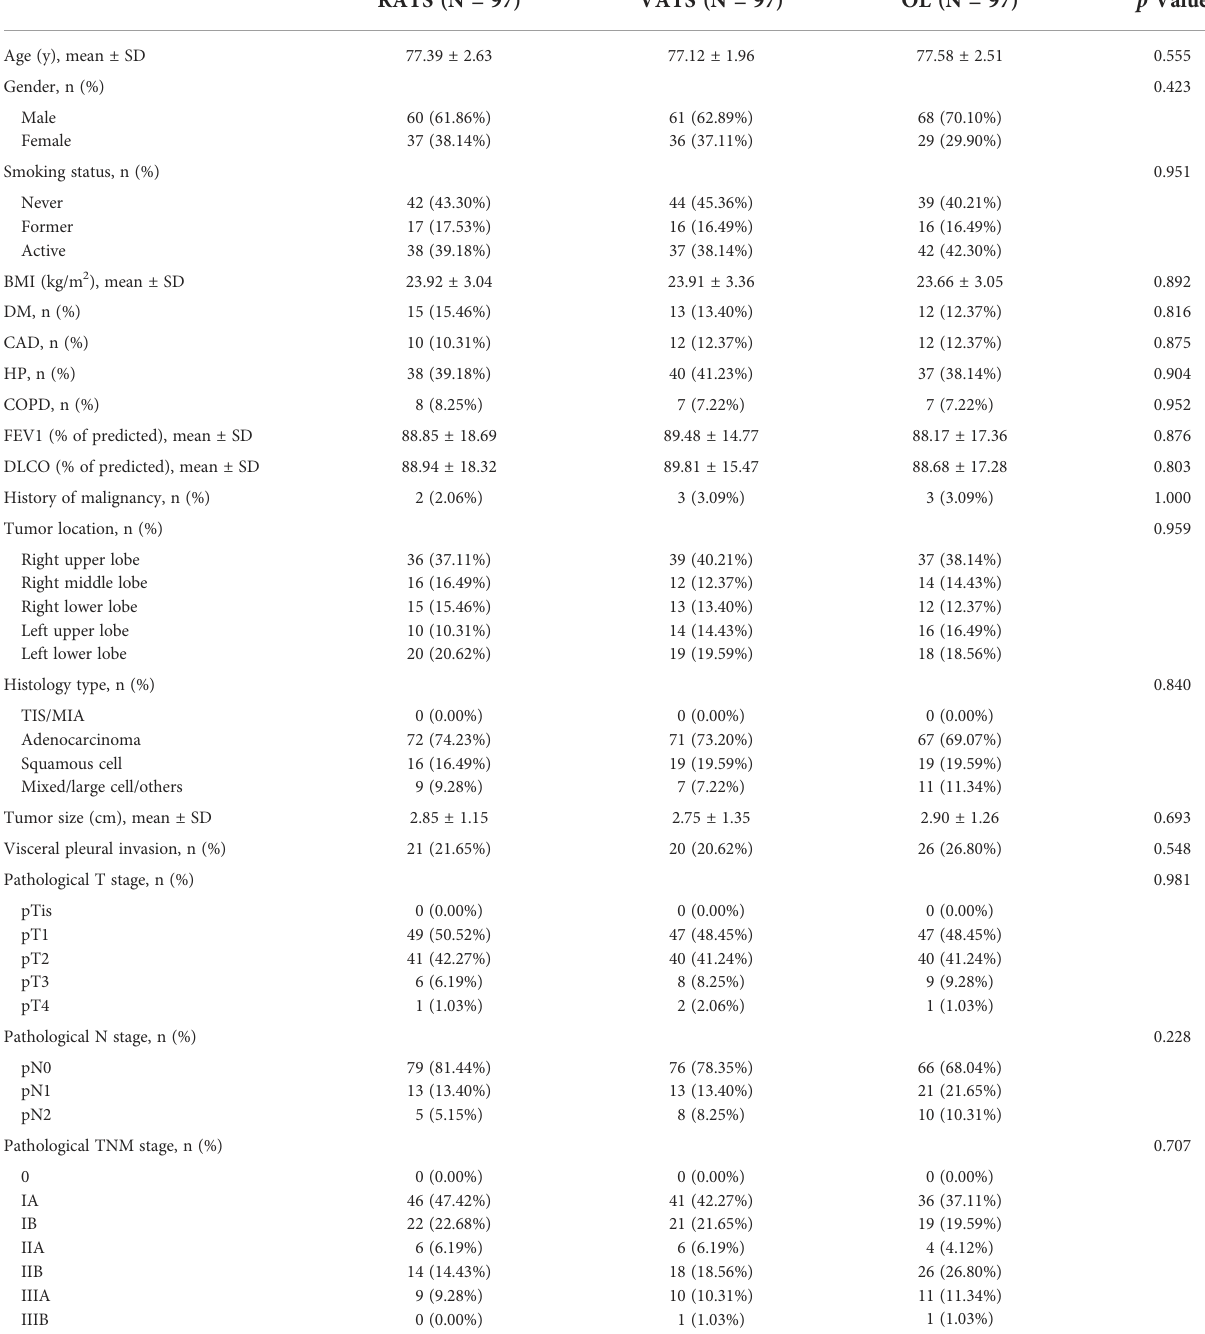
TABLE 2 Baseline clinicopathological characteristics of matched